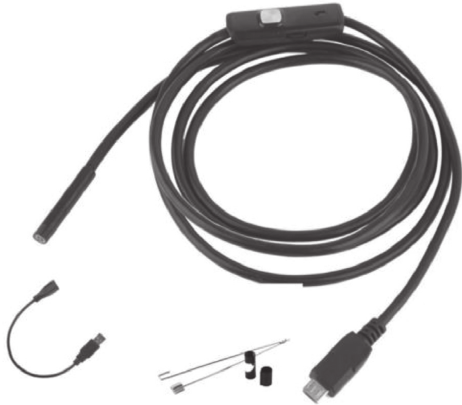
Figure 3: 5.5mm snake tube endoscope. Table 1: Main physical and mechanical parameters of loess